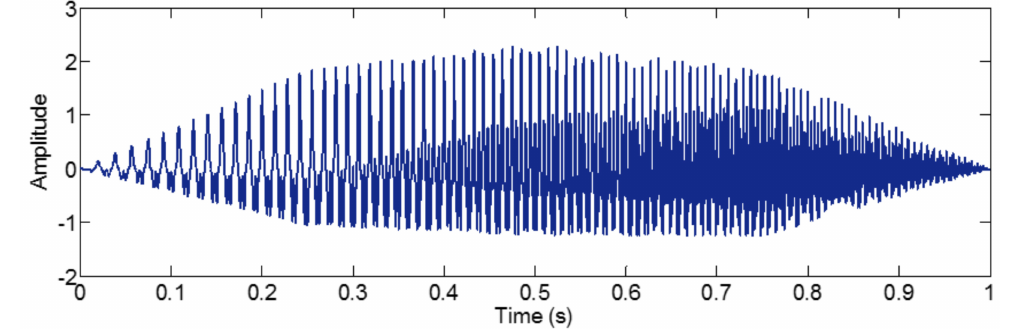
Figure 26. The waveform of the sample signal f sig 6 .